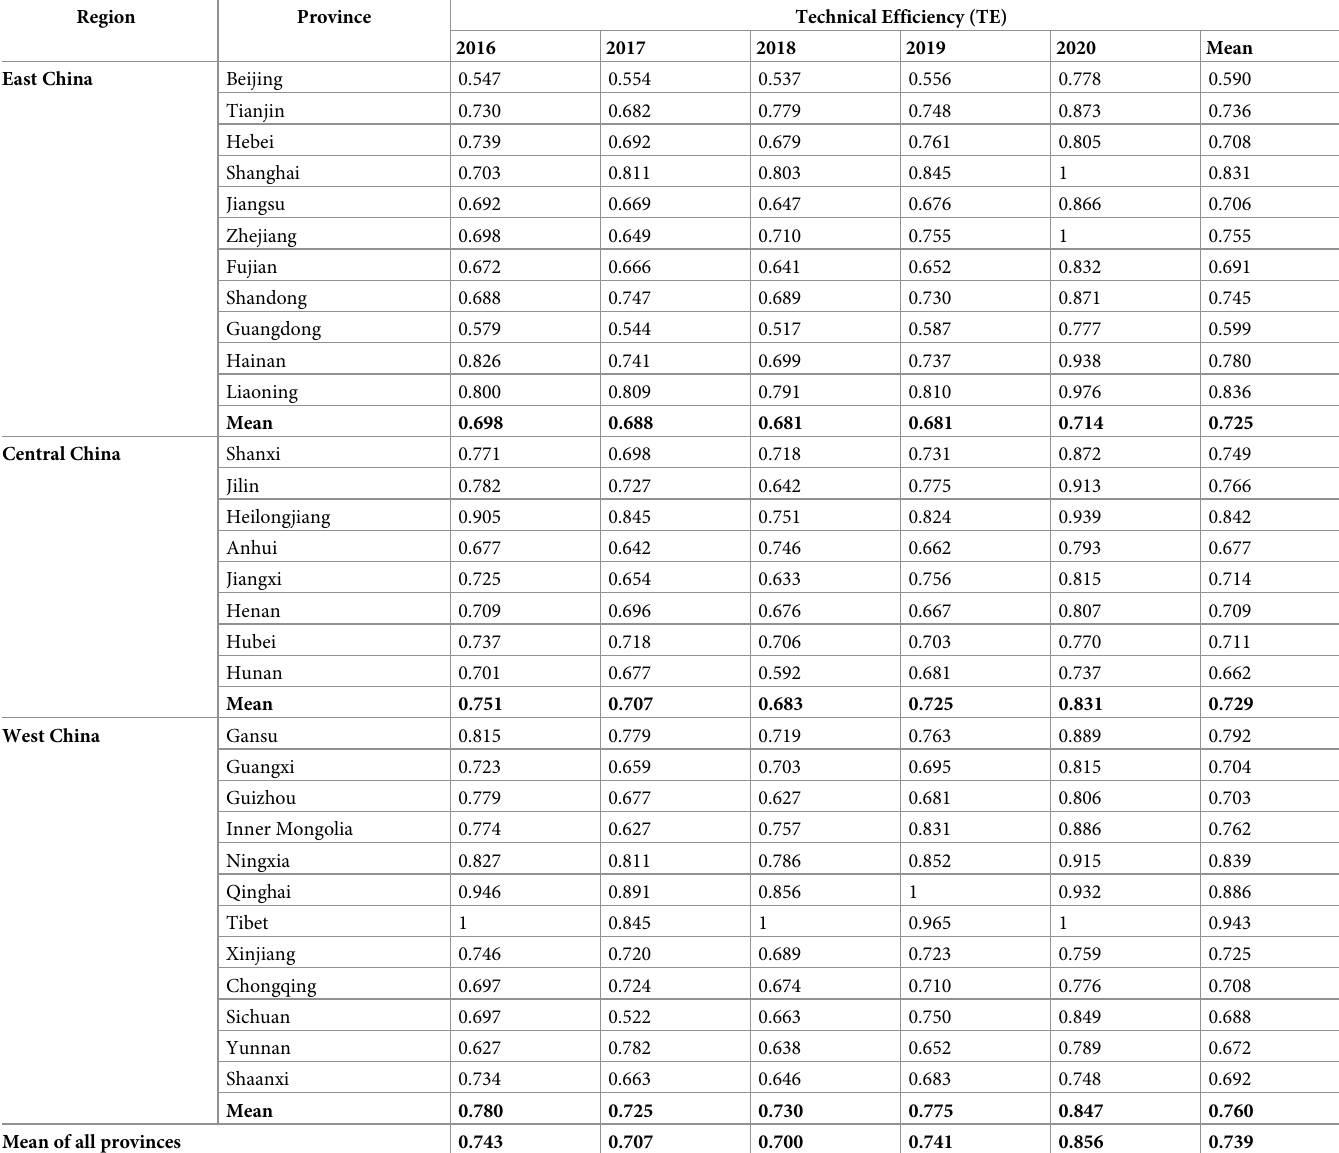
Table 3. Comprehensive technical efficiency of China’s UEBEI from 2016 to 2020. Region